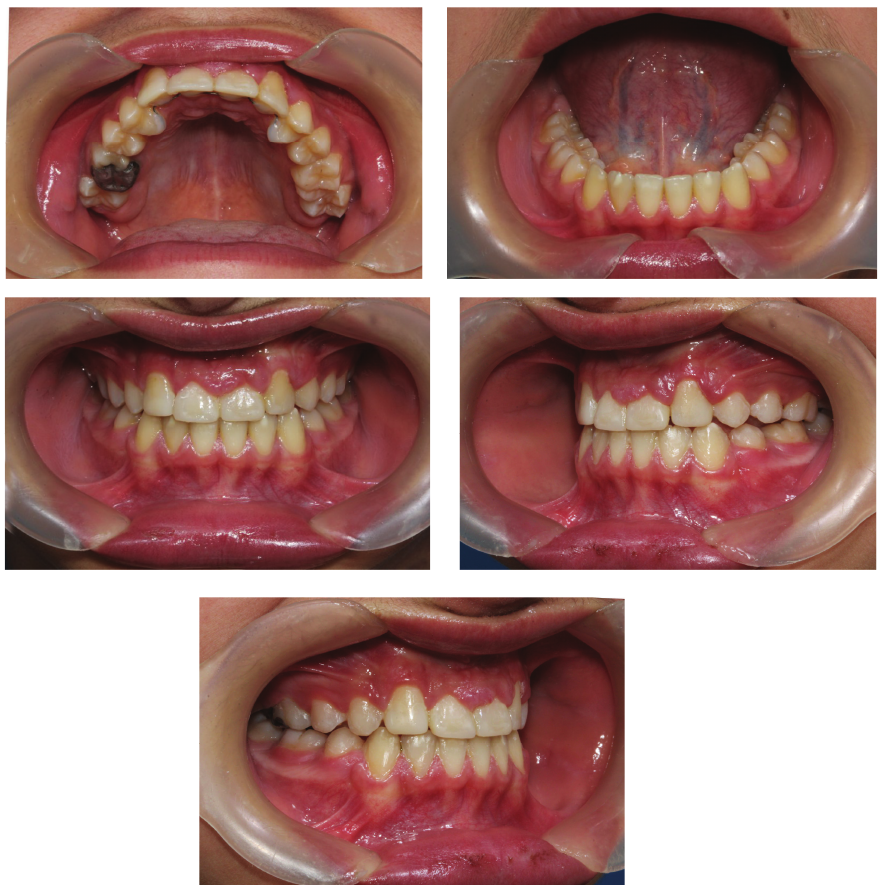
Figure 5: Posttreatment intraoral